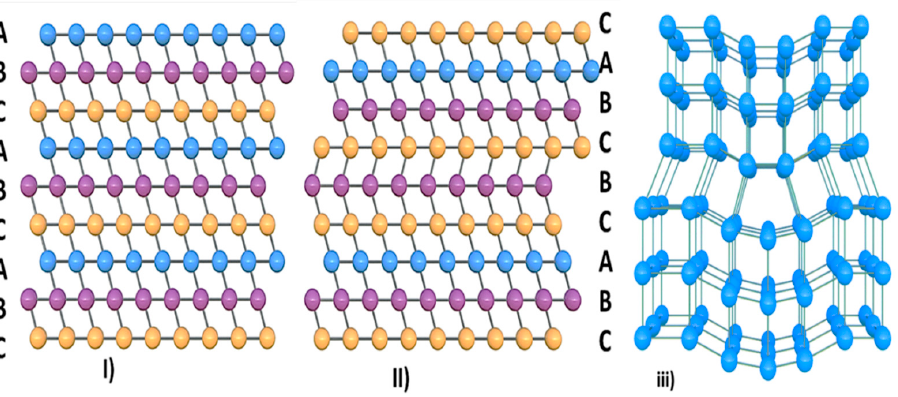
Figure 8. Schematic of defects in TMDC materials: ( i ) perfect crystal; ( ii ) stacking defect; and ( iii ) line defect.